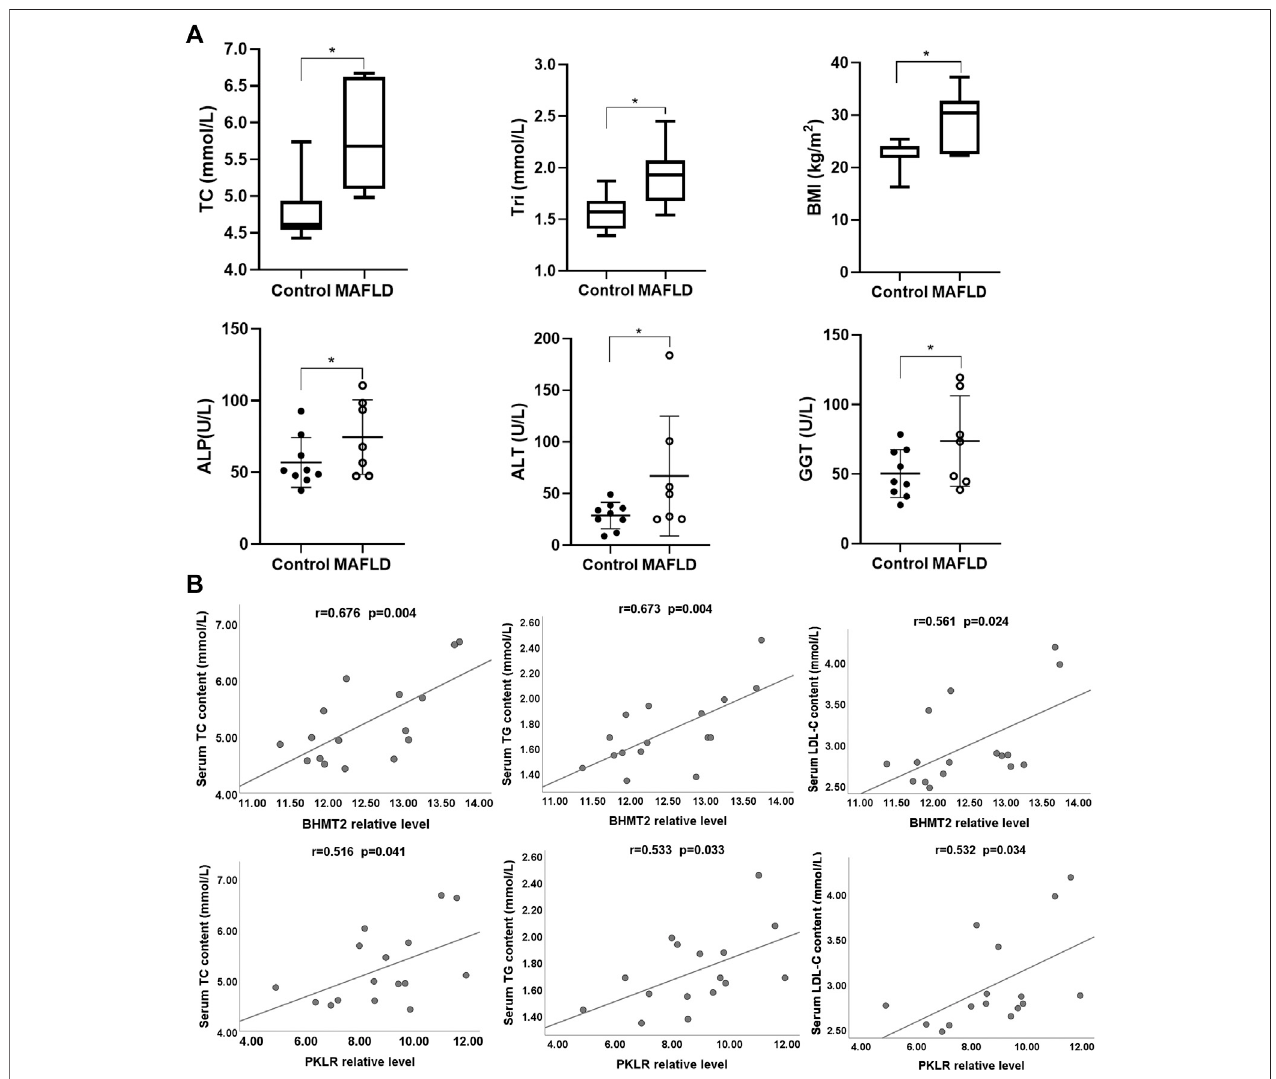
FIGURE 6 | Analysis of BHMT2 and PKLR with clinical parameters. (A) Comparative analysis of clinical indicators between MAFLD patients and controls. (B) Correlation analysis between BHMT2, PKLR with serum TC, TG, and LDL-C levels. BMI, body mass index; ALT, alanine aminotransferase; ALP, alkaline phosphatase; GGT, γ -glutamyl transpeptidase; TC, total cholesterol; Tri (TG), Triglycerides. (* p < 0.05; ** p < 0.01; *** p < 0.001).